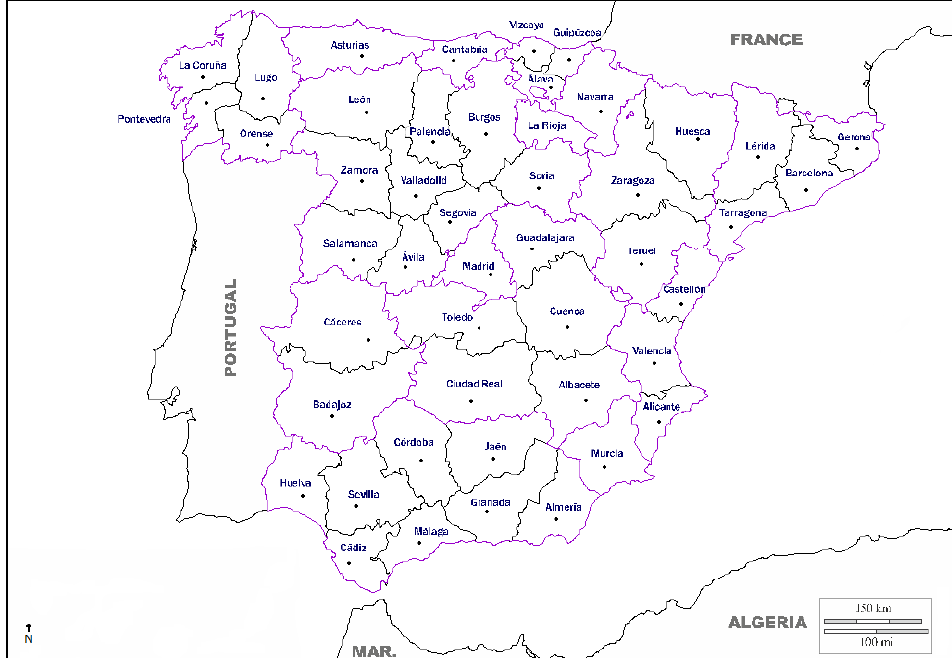
Figure 1. Location of stations in provincial capitals of mainland Spain.